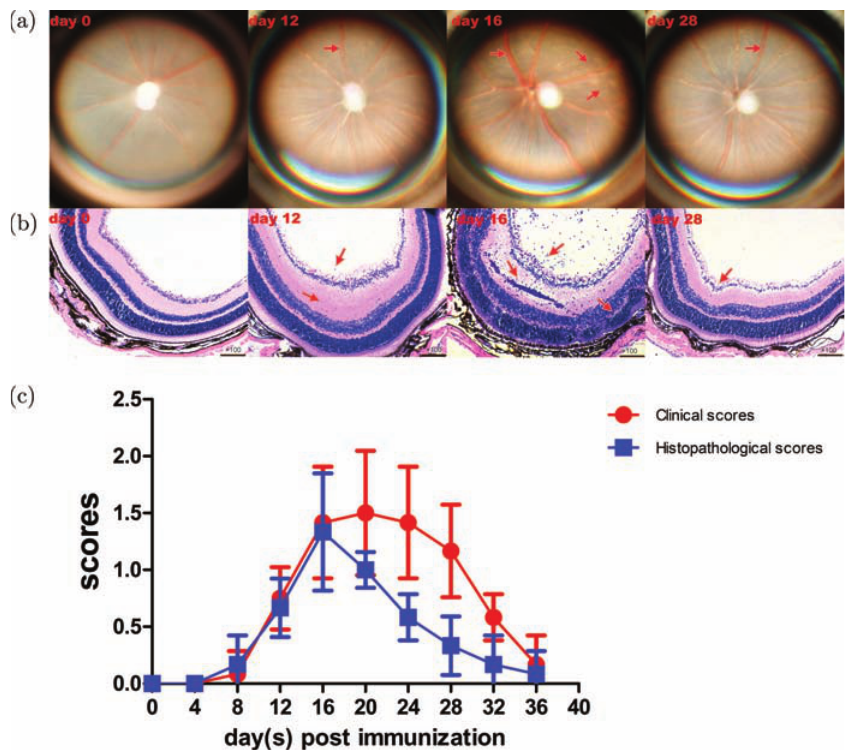
Fig. 1. EAU model creation. (a) B6 mice were immunized subcutaneously with IRBP 1 (cid:1) 20 , and disease symptoms were evaluated by fundoscopy. Minimal vasculitis was observed on day 12. Multifocal chorioretinal lesions, severe vasculitis, and linear lesions were observed on days 16 – 20. Ocular in°ammation was gradually resolved on day 28. (b) Histopathology of a representative eye section from control (day 0) and IRBP 1 (cid:1) 20 – immunized mice on days 12, 16, and 28 (hematoxylin and eosin; original magni¯cation, (cid:2) 100). Image of a representative eye on day 16 after immunization (in the severe in°ammation phase) shows heavy cell in¯ltration and retinal folds (arrows). (c) EAU scores after immunization. The data presented are the average scores of three separate experiments. The results are expressed as mean (cid:4) SD ( n ¼